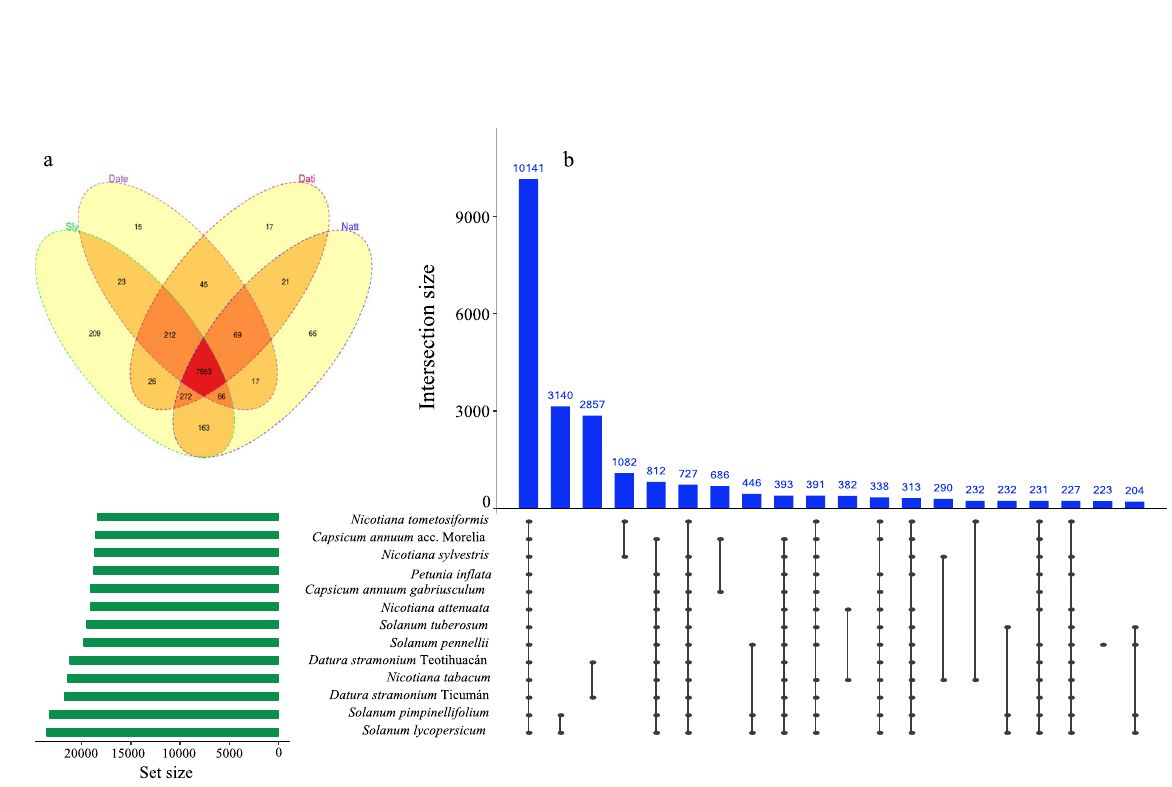
Figure 3. ( a ) Venn diagram shows 7653 InterProscan domains that are shared between Datura stramonium Teotihuacán (Date), Solanum lycopersicum (Sly), Datura stramonium Ticumán (Dati) and Nicotiana attenuata (Natt). 15 and 17 domains are exclusive for D. stramonium Teotihuacán and Ticumán, respectively. The UpSet plot shows the intersections of the set of orthogroups from the thirteen Solanaceae genomes. Each column corresponds to an orthogroup, and each row corresponds to one segment in a Venn diagram. Cells are either empty (grey-black), indicating that this set is not part of that intersection, or filled, showing that the set is participating in the intersection and that the species share that orthogroup. OrthoFinder assigned 480,594 genes out of 536,483 (89.6% of total) to 35,458 orthogroups or gene families. Solanum pimpinellifolium and Solanum lycopersicum were the species-pair with more orthogroups shared (3140), followed by the pair between Datura stramonium Ticumán and Teotihuacán (2857 shared